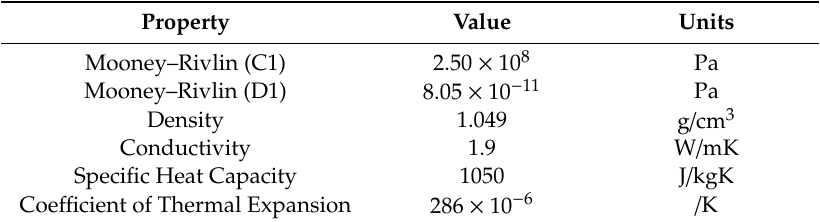
Table 1. Silicone rubber material (Mooney–Rivlin